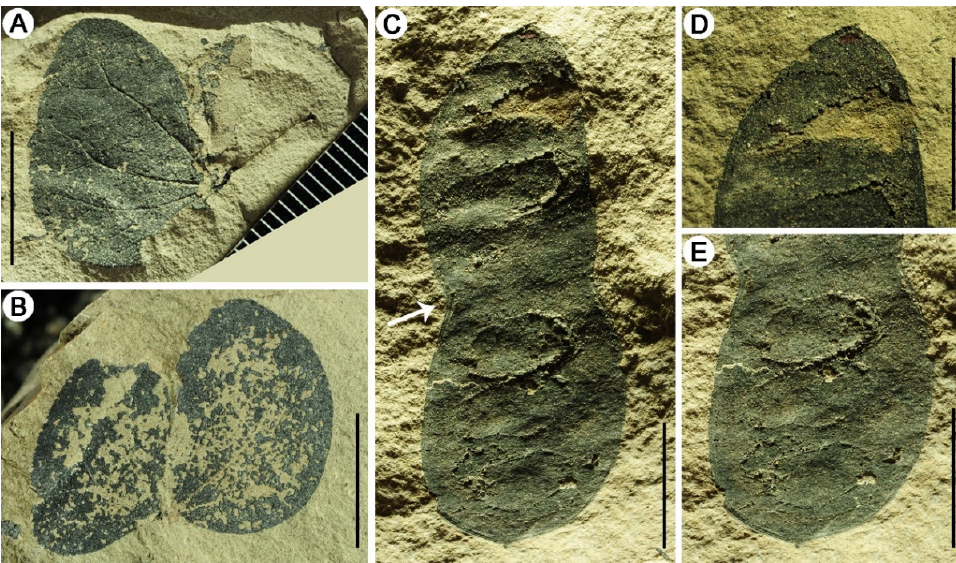
Figure 6. Leaf morphologies of Bauhinia sp. (morphotype 3) and fruit morphology of cf. Bauhinia sp. (morphotype 4). The scale bars represent 1 cm. ( A ) FN0189; ( B ) FN0616; ( C – E ) FN0465.